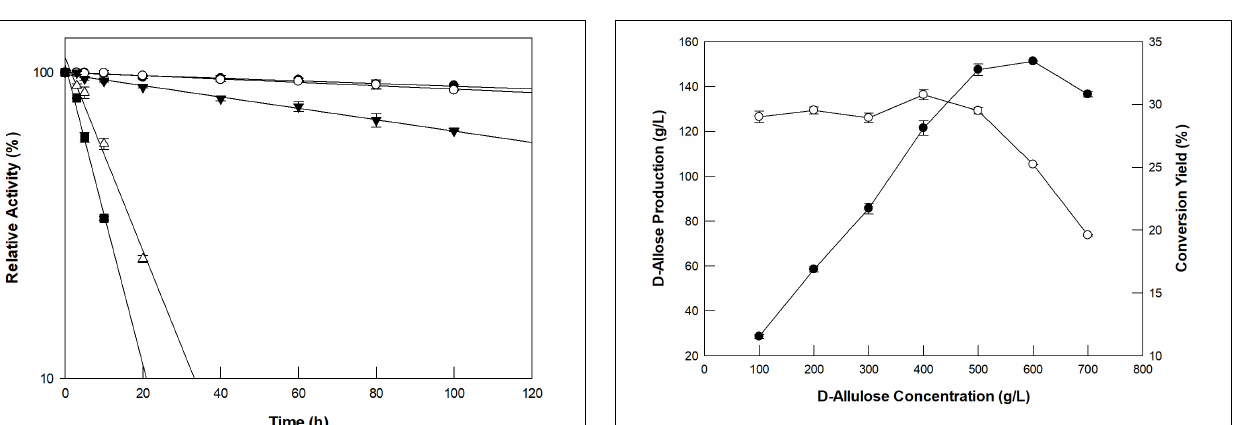
FIGURE 2 | Thermal inactivation of GI catalyzing D -allose production at 50 ◦ C (closed circles), 60 ◦ C (open circles), 70 ◦ C (closed inverted triangles), 80 ◦ C (open triangles), and 90 ◦ C (closed squares). The enzyme was incubated at temperatures ranging from 50 to 90 ◦ C for varying periods of time. A sample was withdrawn at each time interval and assayed for enzyme activity in 50 mM EPPS buffer (pH 8.0) containing 10 g/L D -allulose at 60 ◦ C for 30 min. The experimental data for thermal deactivation of the enzyme were fitted to a first-order curve and the half-life of the enzyme was calculated using Sigma plot 10.0 software (Systat software, San Jose, CA, United States). Data represent the means of three experiments ± standard deviation (SD).